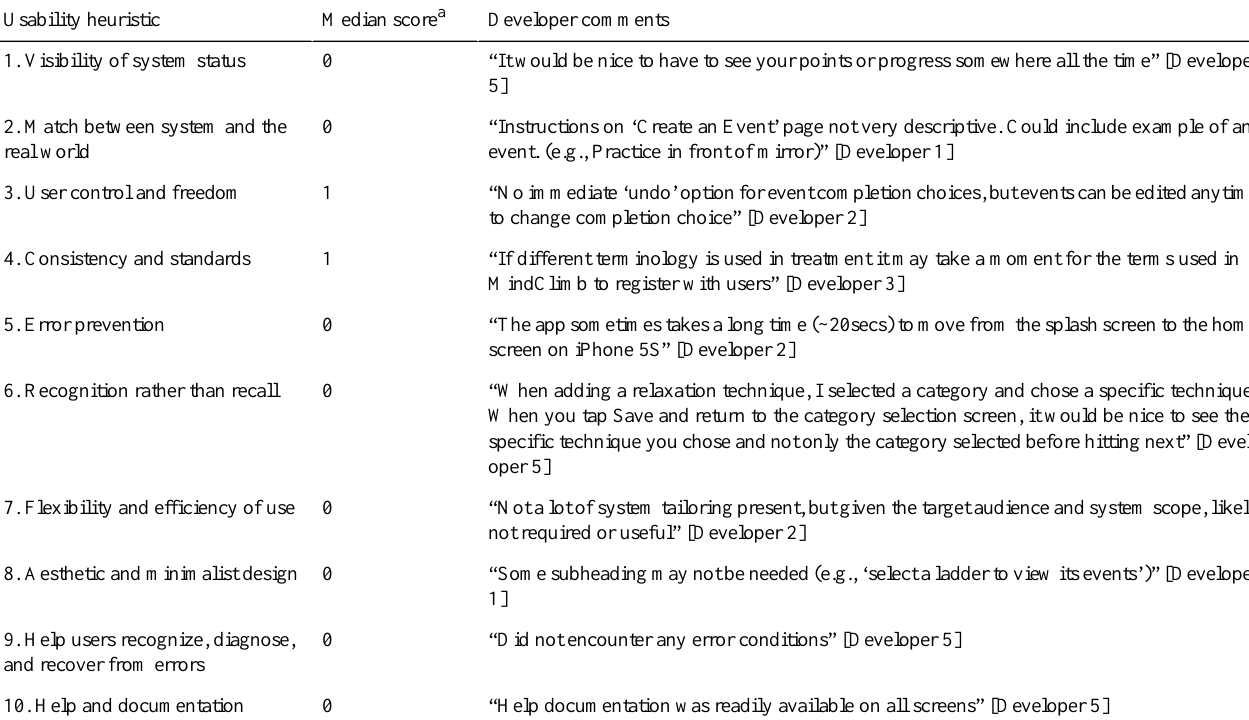
Table 3. Severity ranking scale results from mobile app developers.